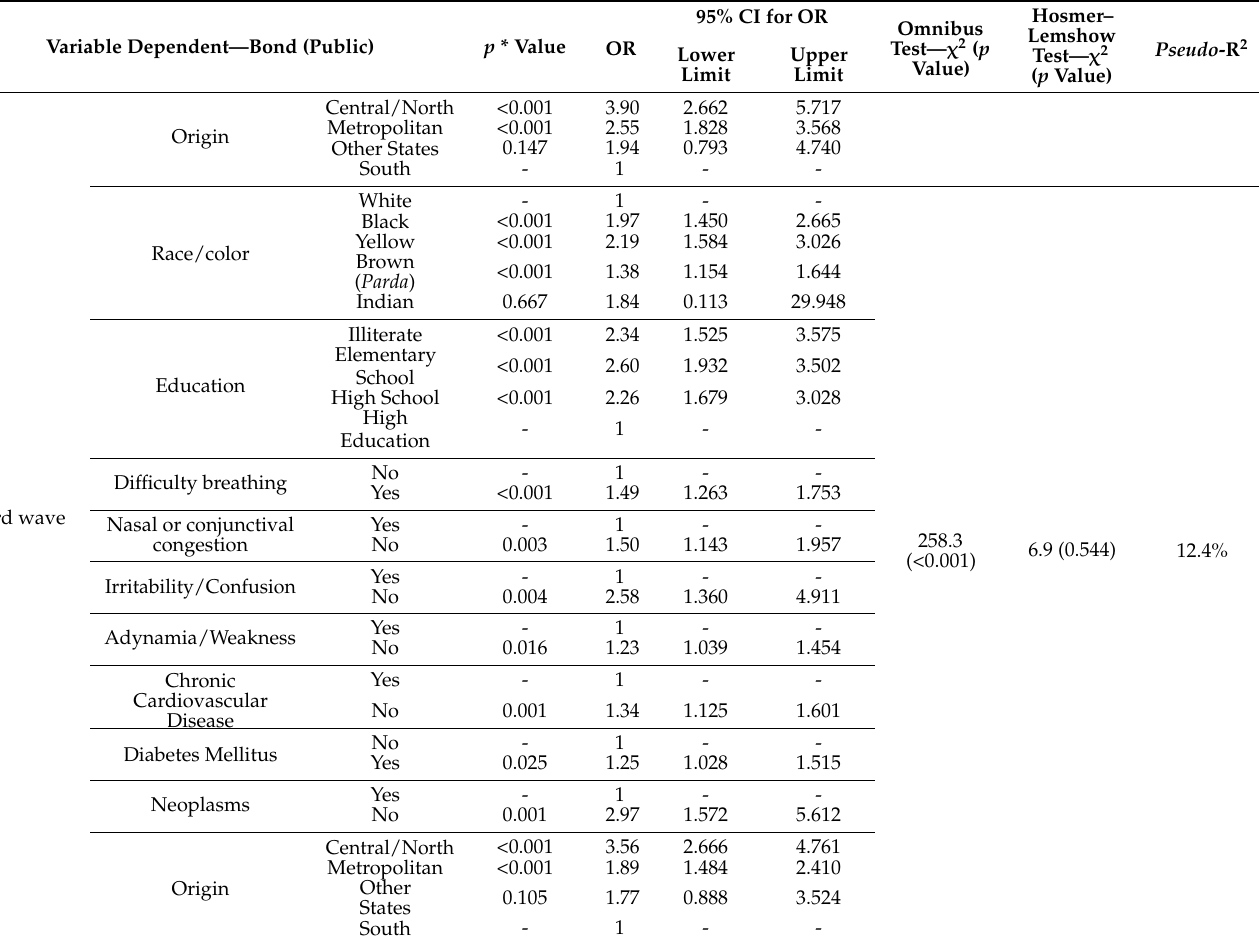
Table 4. Association of the public bond with the socio-clinical variables for the third wave of death incidence. From April 2020 to August 2021, Esp í rito Santo,